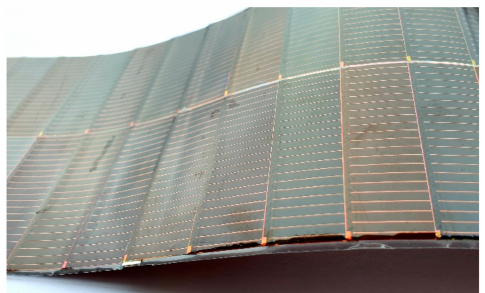
Figure 2. Example of a flexible solar